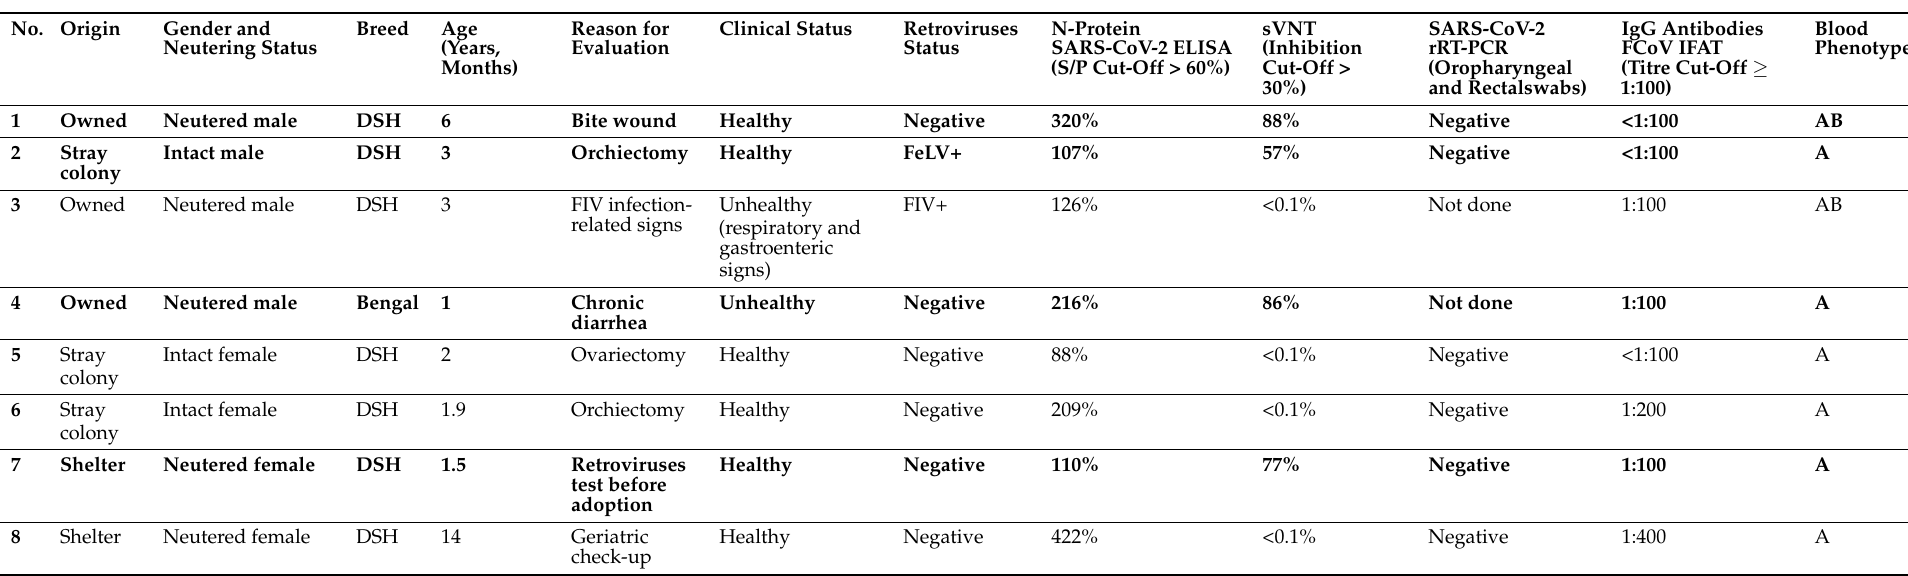
Table 2. Demographic, history, clinical, and laboratory data of SARS-CoV-2 seropositive cats evaluated for the effect of blood phenotypes A, B, and AB